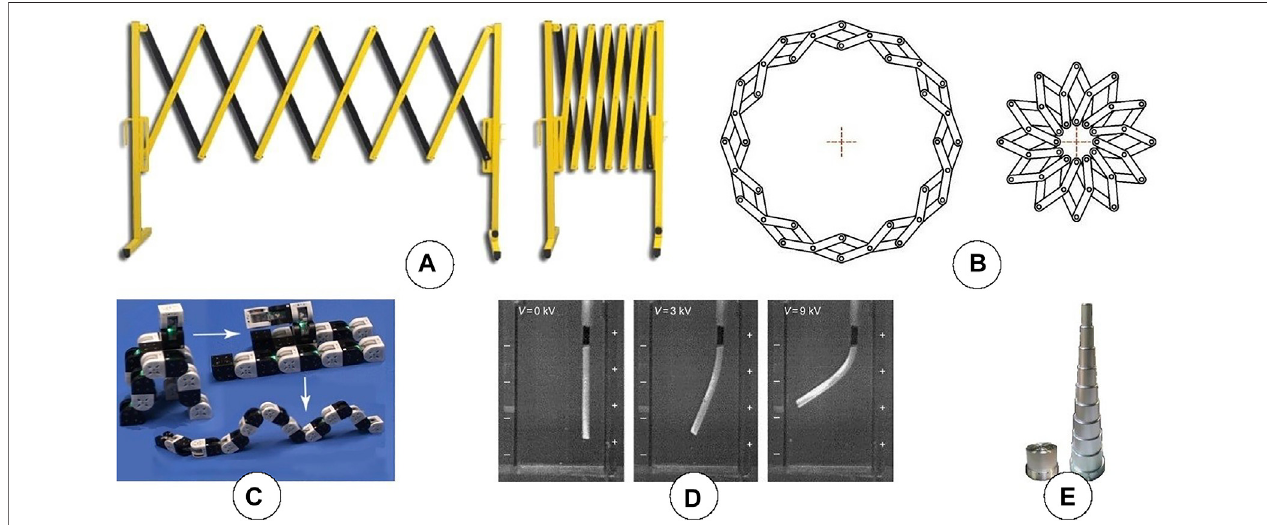
FIGURE 4 | (A) A scissor-like expandable structure, capable of expanding linearly. (B) A Hoberman linkage, capable of expanding radially. (C) A chain-type expandable structure,capable ofexpandingvarious components inall directions inspace(Kurokawa et al.,2008). (D) An electro-activepolymer, whichmay be capable of forming different shapes. (E) A telescopic